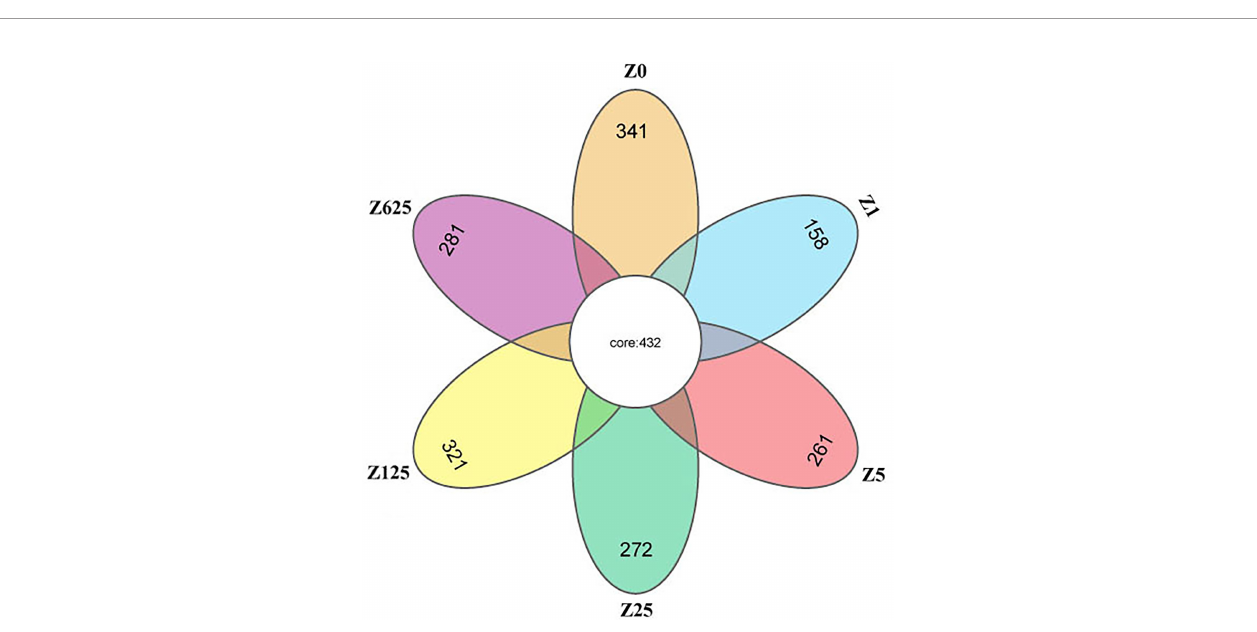
FIGURE 5 | Venn diagram for the comparison of operational taxonomic units